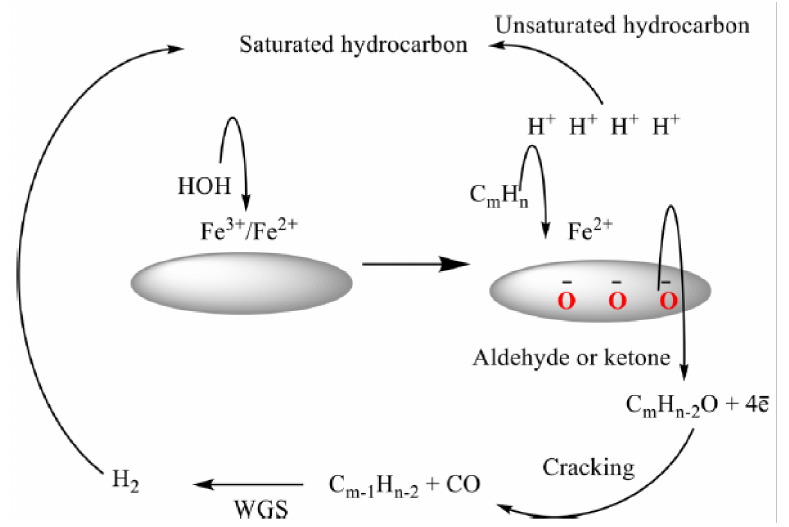
Figure 8. Upgrading mechanism of heavy crude oil by using an Fe 3 O 4 /MWCNT@EFHIA cata- lyst